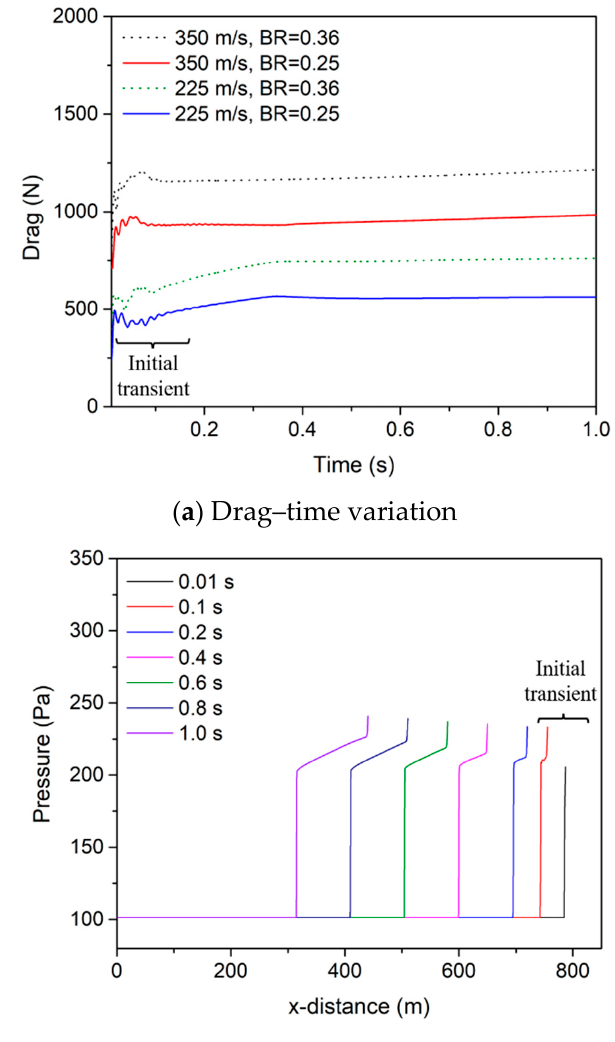
Figure 4. Variation of ( a ) drag and ( b ) compression wave propagation with respect to time in unsteady conditions. All results after the initial transients are analyzed.